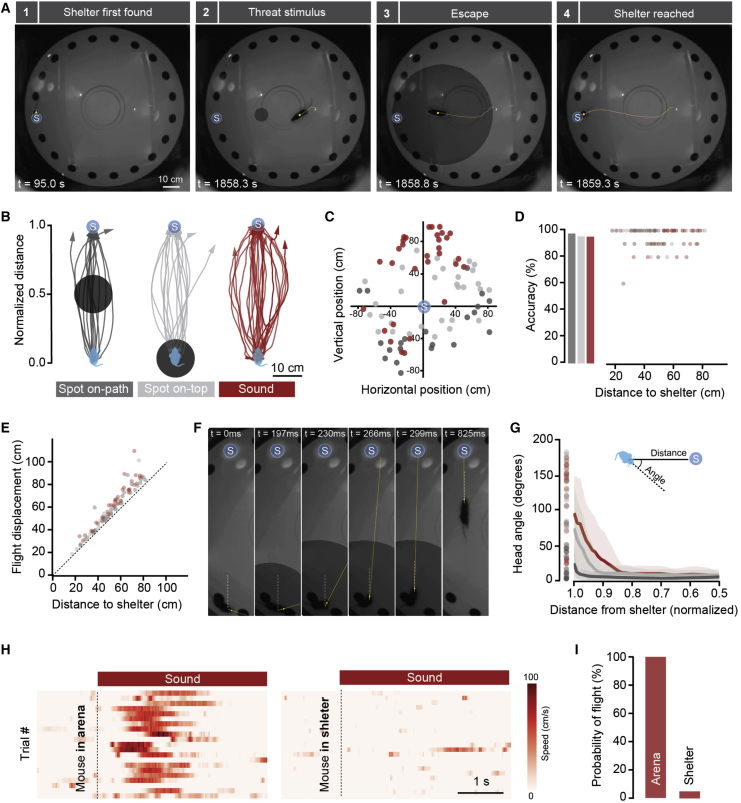
Escape Behavior Is a Goal-Directed Action to Reach Safety(A) Video frames from one trial showing escape to a previously explored shelter after stimulation with an expanding spot projected from above, between the mouse and the shelter location (on-path). Yellow lines indicate the mouse’s trajectory during the preceding 2 s.(B) Example trajectories from several mice, recorded between stimulus onset and the end of flight, showing that flight path and target are independent of stimulus position or quality (number of animals = 10 on-path, 16 on-top, and 15 sound).(C) Initial position of mice in all trials plotted in relation to the shelter location.(D) Accuracy of reaching the shelter during escape. Bars show average accuracy and circles are individual accuracy data points as function of distance to the shelter.(E) Total displacement during escape for 100% accurate flights plotted against linear distance to the shelter.(F) Video frames from one trial during initiation of escape from an expanding spot on-top, highlighting the initial head rotation preceding the initiation of running. The yellow line indicates head direction, and the dashed white line is the reference line between the current mouse position and the shelter.(G) Head angles measured between the white and yellow lines illustrated in (F) for 100% accurate flights, showing that the head is pointing toward the position of the shelter before the distance to the shelter is covered. Circles indicate the initial angles for different trials, lines indicate average head rotation profile, and shaded areas indicate the SD (n = 59 trials from 38 animals).(H) Raster plots showing speed profile of trials in several mice stimulated with sound when exploring the arena (left) or when the same mice were inside an over-ground shelter (right).(I) The probability of flight is dramatically reduced when animals are already inside a shelter.For all relevant panels, the blue circle with “S” identifies the shelter location and dark gray, light gray, and red indicate data from stimulation with spot on-path, spot on-top, and sound, respectively. See also Figure S1 and Movie S1.